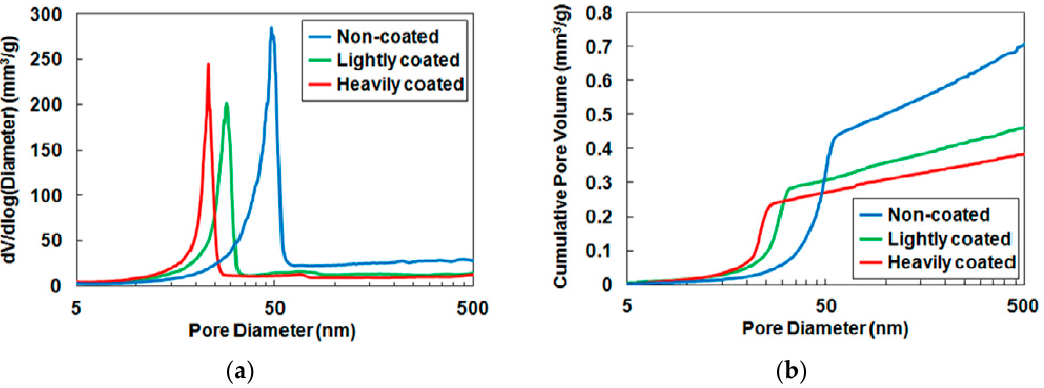
Figure 5. Typical data from mercury intrusion porosimetry for the non-coated, lightly fatty acid-coated, and heavily fatty acid-coated CaCO 3 powders; ( a ) Differential intrusion volume plot; ( b ) Cumulative pore volume plot.